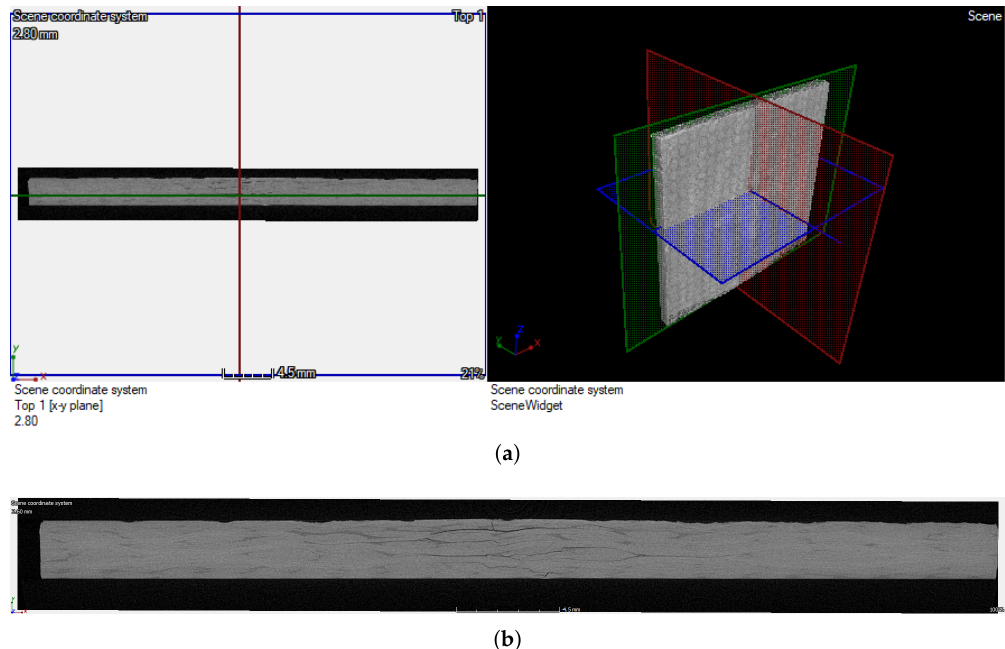
Figure 1. The view of the XCT scan of the tested specimen ( a ), and the exemplary slice in the normal direction to the specimen’s surface ( b